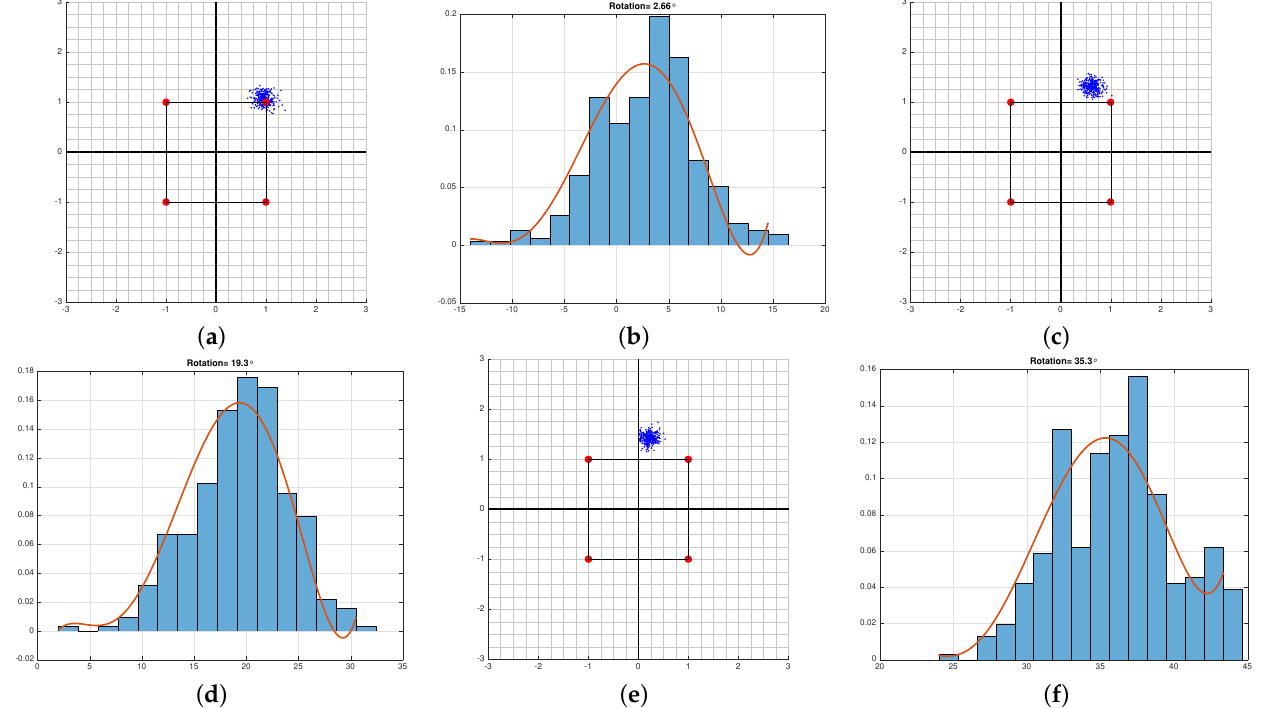
Figure 5. Phase trajectory build by estimation of phase rotation per block. Block lengths are chosen short enough to keep the phase trajectory linear. ( a ) Phase offset snapshot 1, ( b ) Phase offset historgram used for phase estimation, ( c ) Phase offset snapshot 2, ( d ) Phase offset historgram used for phase estimation, ( e ) Phase offset snapshot 3, ( f ) Phase offset historgram used for phase